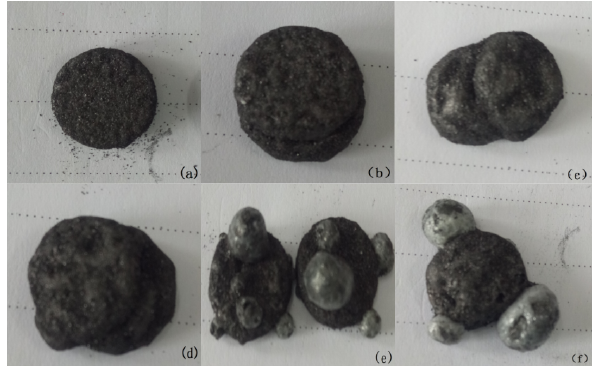
Figure 1: The slag after different reaction time at temperature